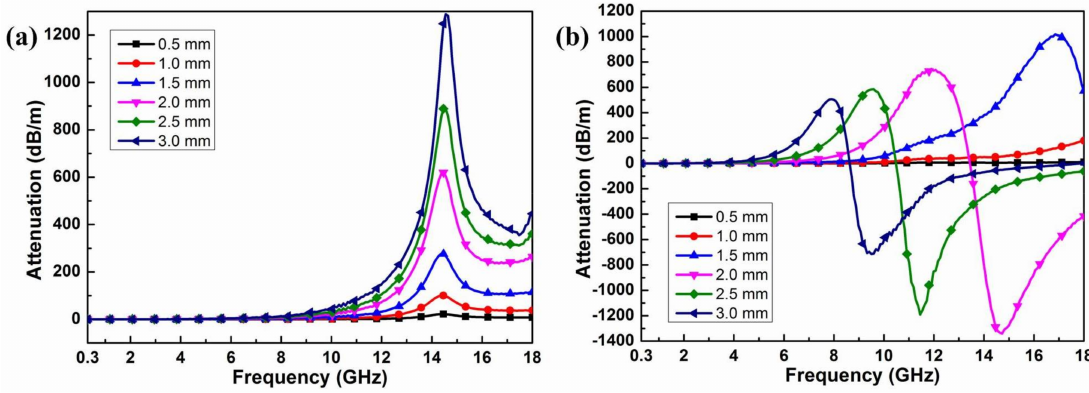
Figure 7. The calculated surface wave attenuation constants: ( a ) Co 0.5 Ni 0.5 Fe 2 O 4 fibers; ( b ) Co 0.5 Ni 0.5 Fe 2 O 4